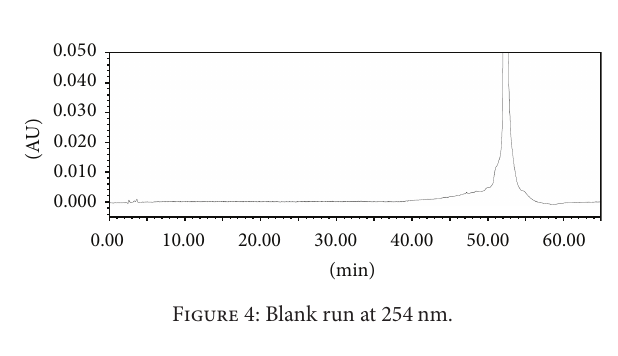
Figure 4: Blank run at 254 nm.